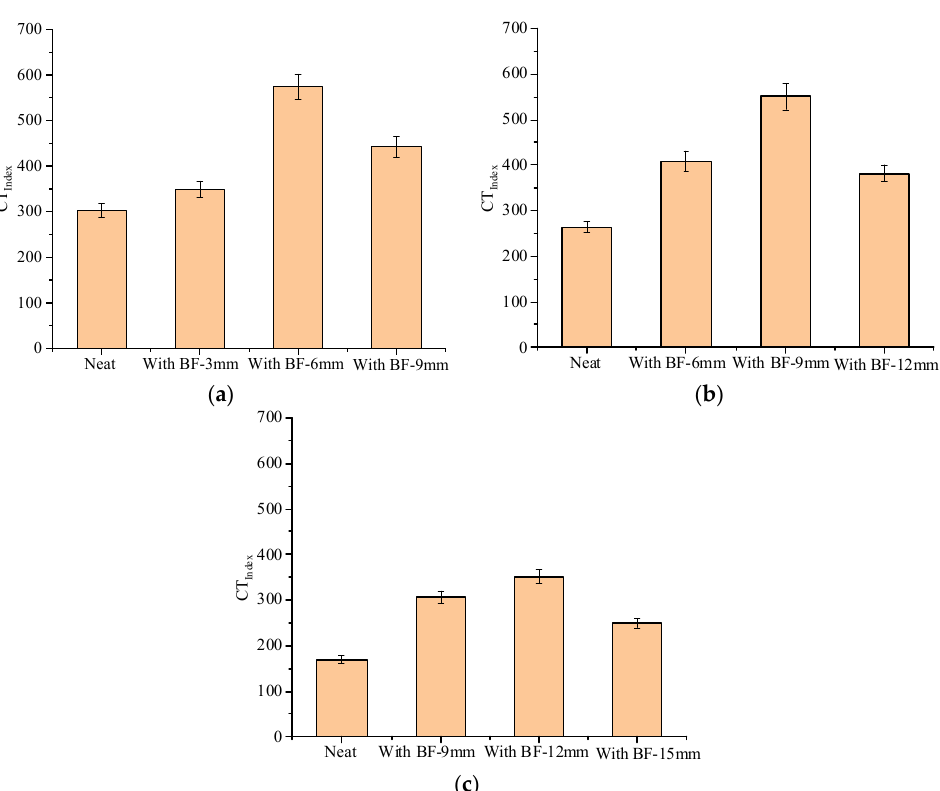
Figure 6. IDEAL cracking test results: ( a ) SUP-13; ( b ) SUP-20; and ( c )